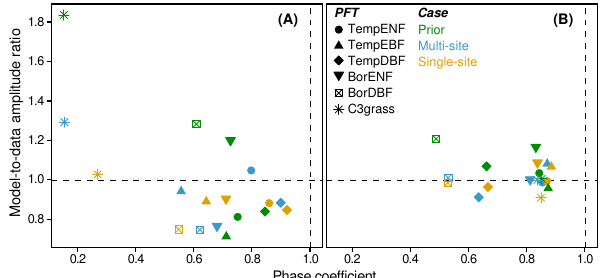
Figure 3. PFT-averaged model phase coefficient versus model-to- data amplitude ratio, for the detrended smooth seasonal cycles of (a) NEE and (b) LE fluxes. Simulations using prior parameters (green) are compared to multisite (blue) and single-site (orange) optimizations, with the measured reference indicated by the inter- section of the dashed